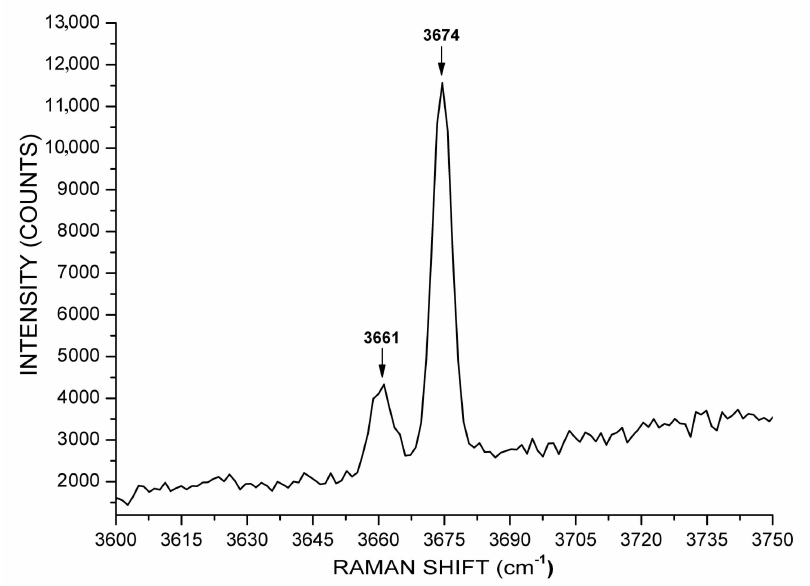
Figure 8. Oscillation bands of OH − -groups in